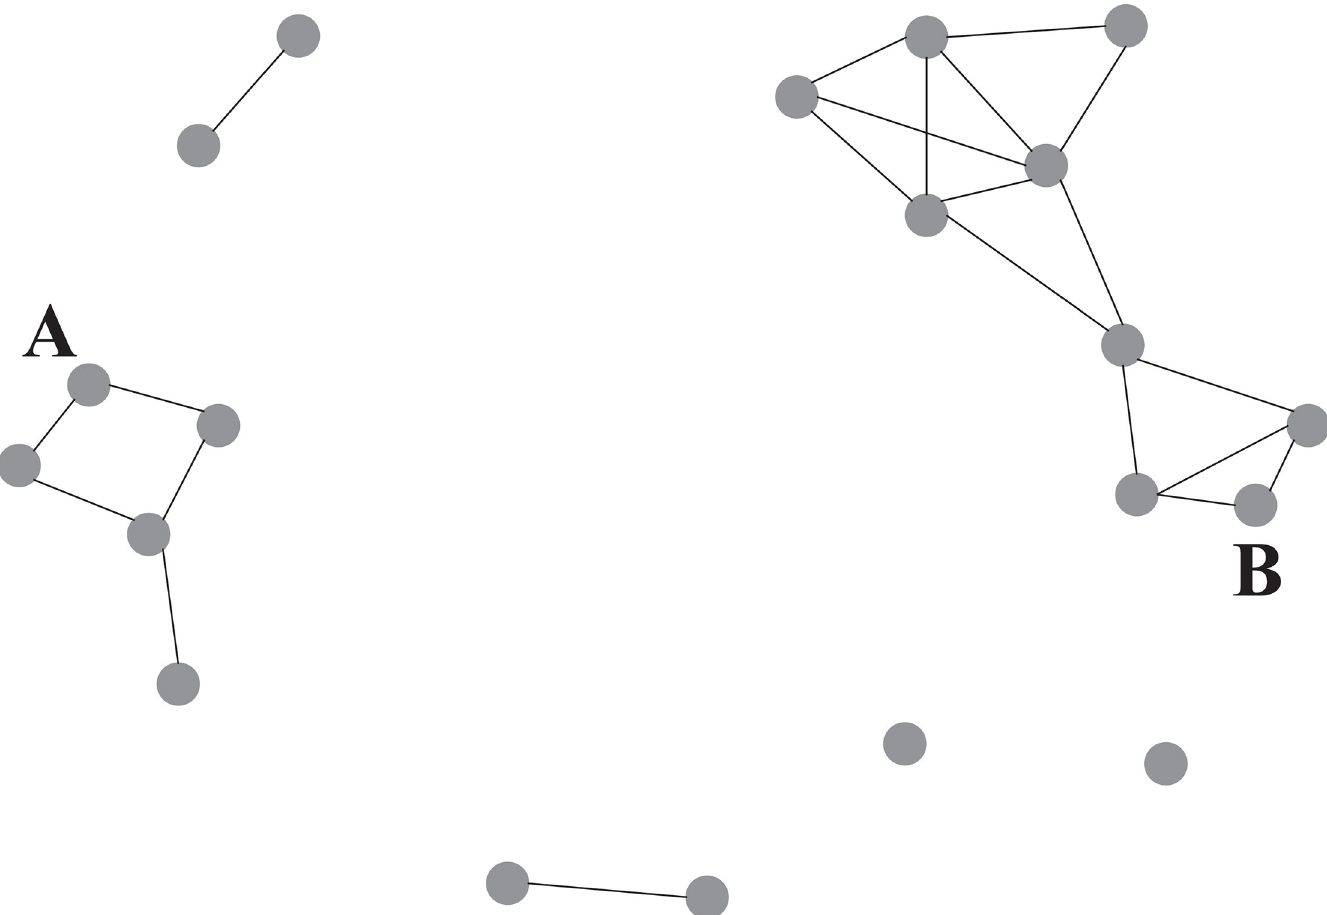
Fig 3. Sociogram of a help network with high segmentation (value .92) and low inequality (value .10), highlighting individuals with relatively low (A) and high (B) centrality.